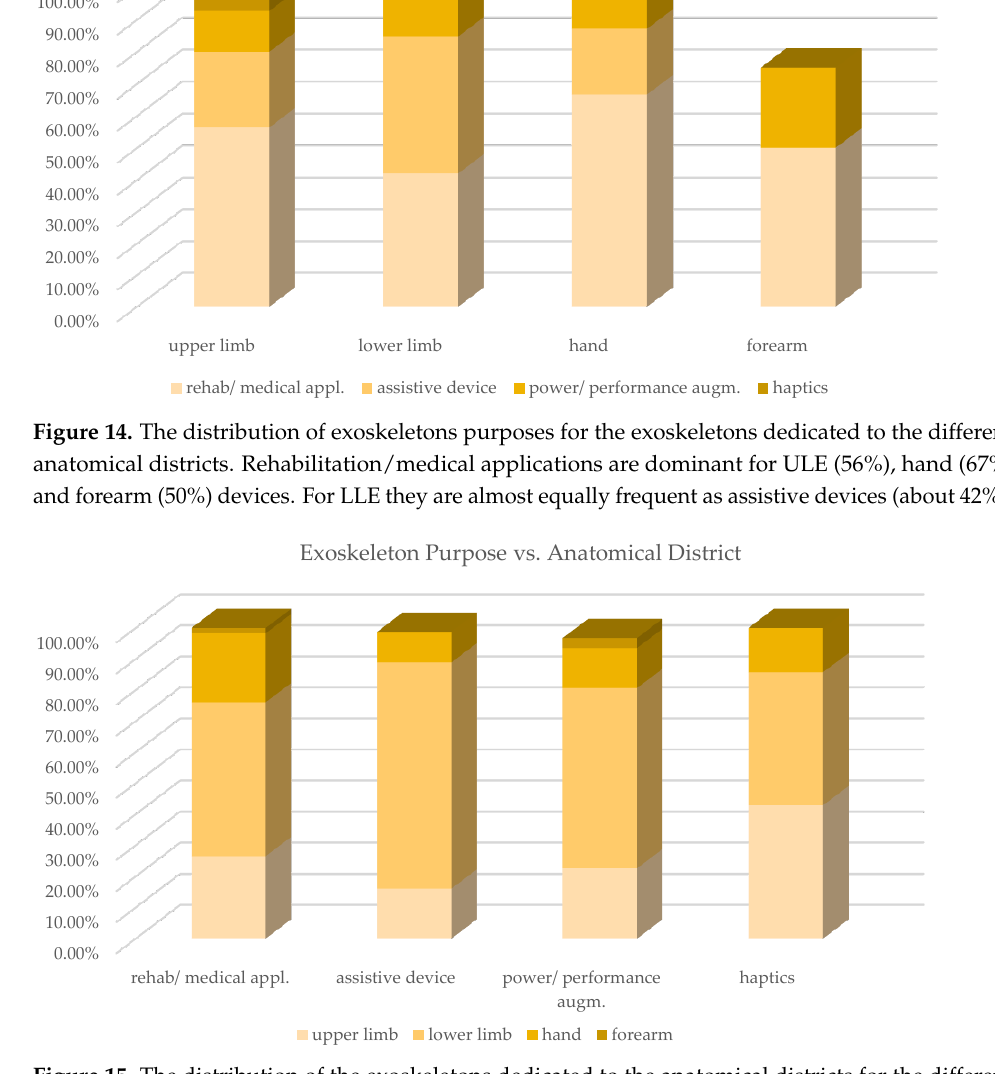
Figure 15. The distribution of the exoskeletons dedicated to the anatomical districts for the different exoskeleton purposes. For Rehabilitation/medical applications, LLE are prevalent (50%), as well as for power/performance augmentation exoskeletons (58%) and even more for assistive devices